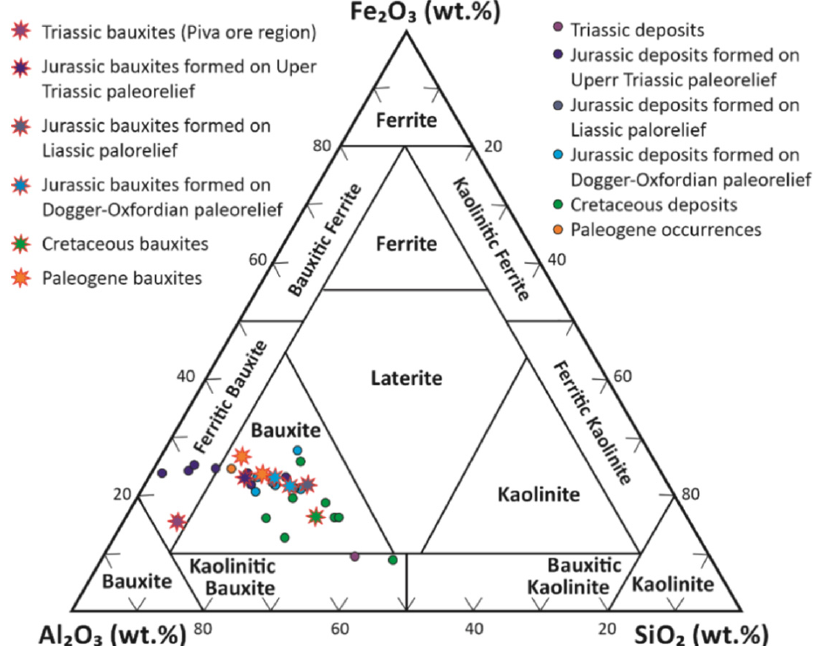
Figure 14. Triangular diagram of SiO 2 -Al 2 O3-Fe 2 O 3 of the bauxite formations and deposits, after Aleva [81].